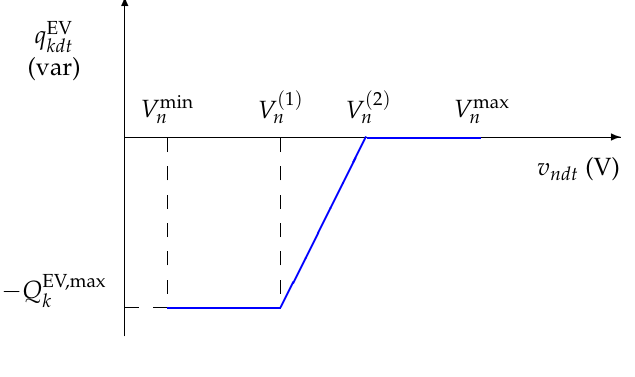
Figure 1. Reactive power-voltage magnitude droop